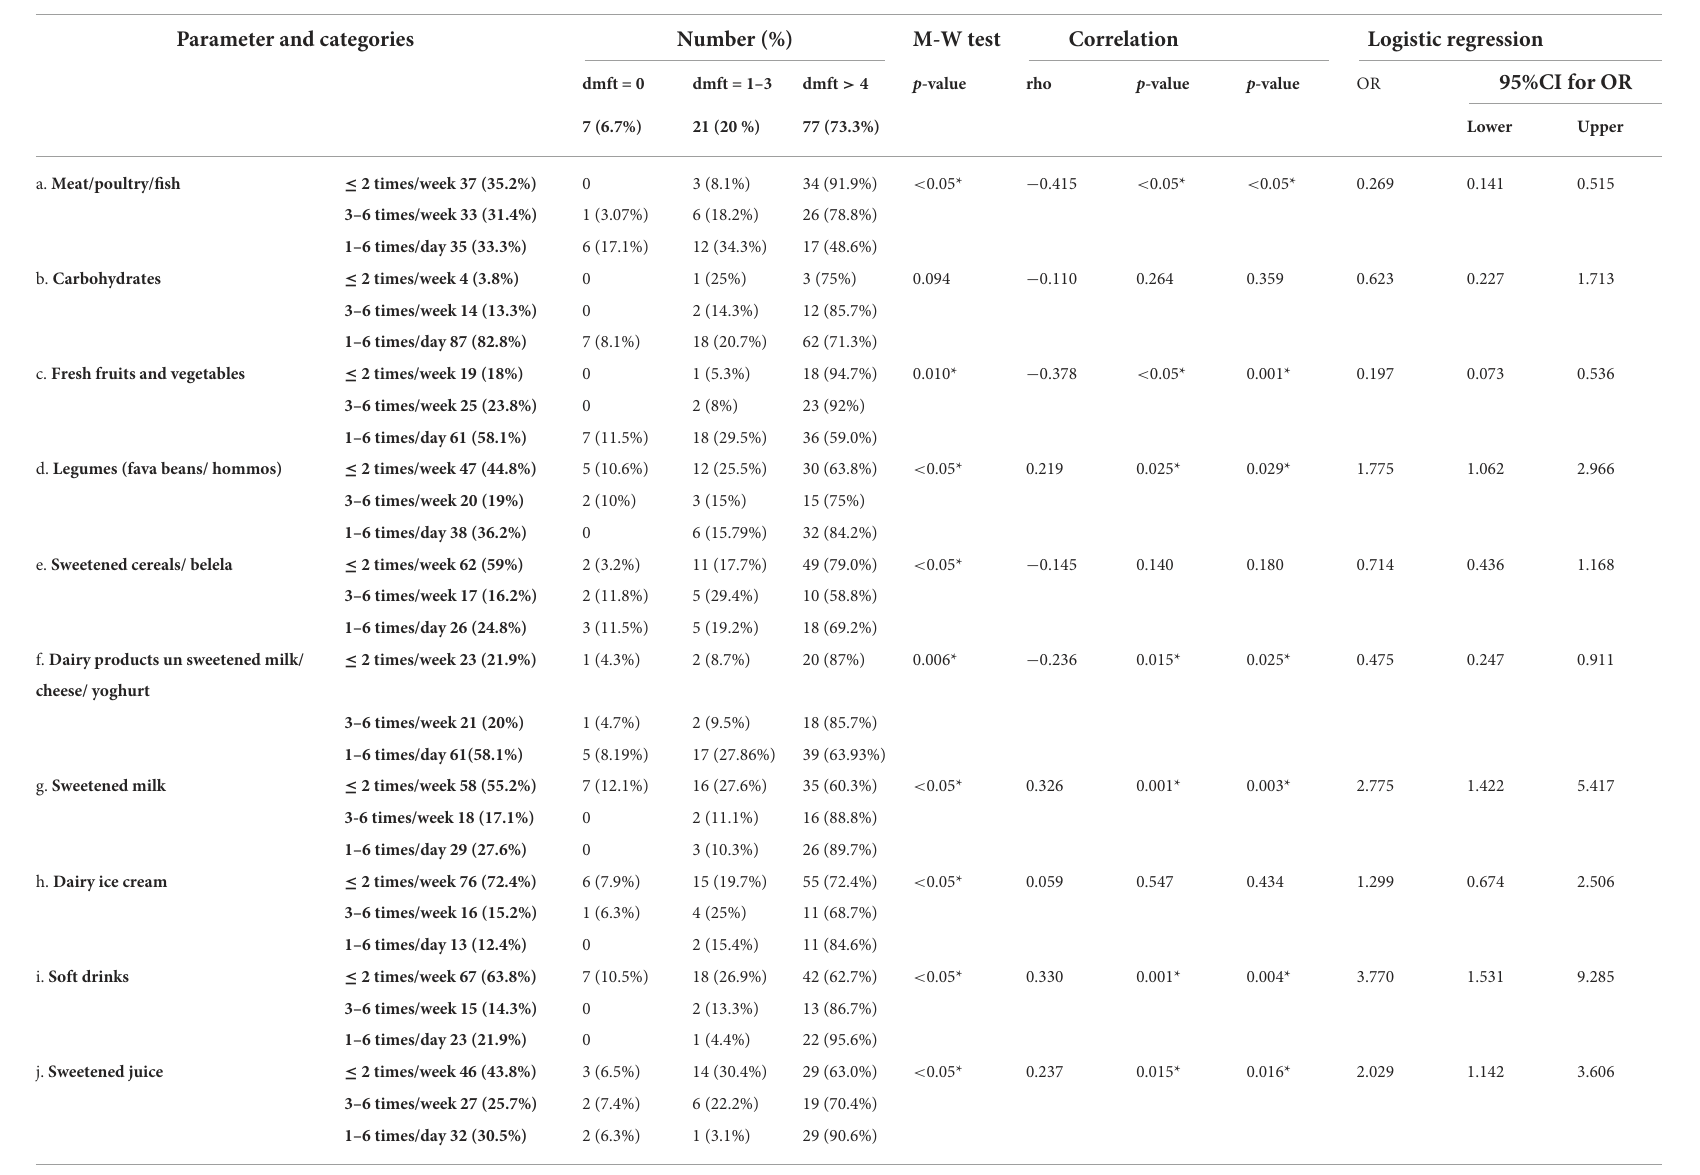
TABLE 5 Correlation between dmft index and frequency of intake of different food items (Total number